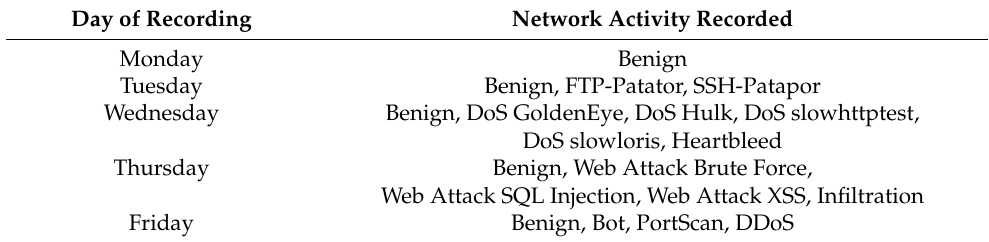
Table 1. CICIDS2017 dataset